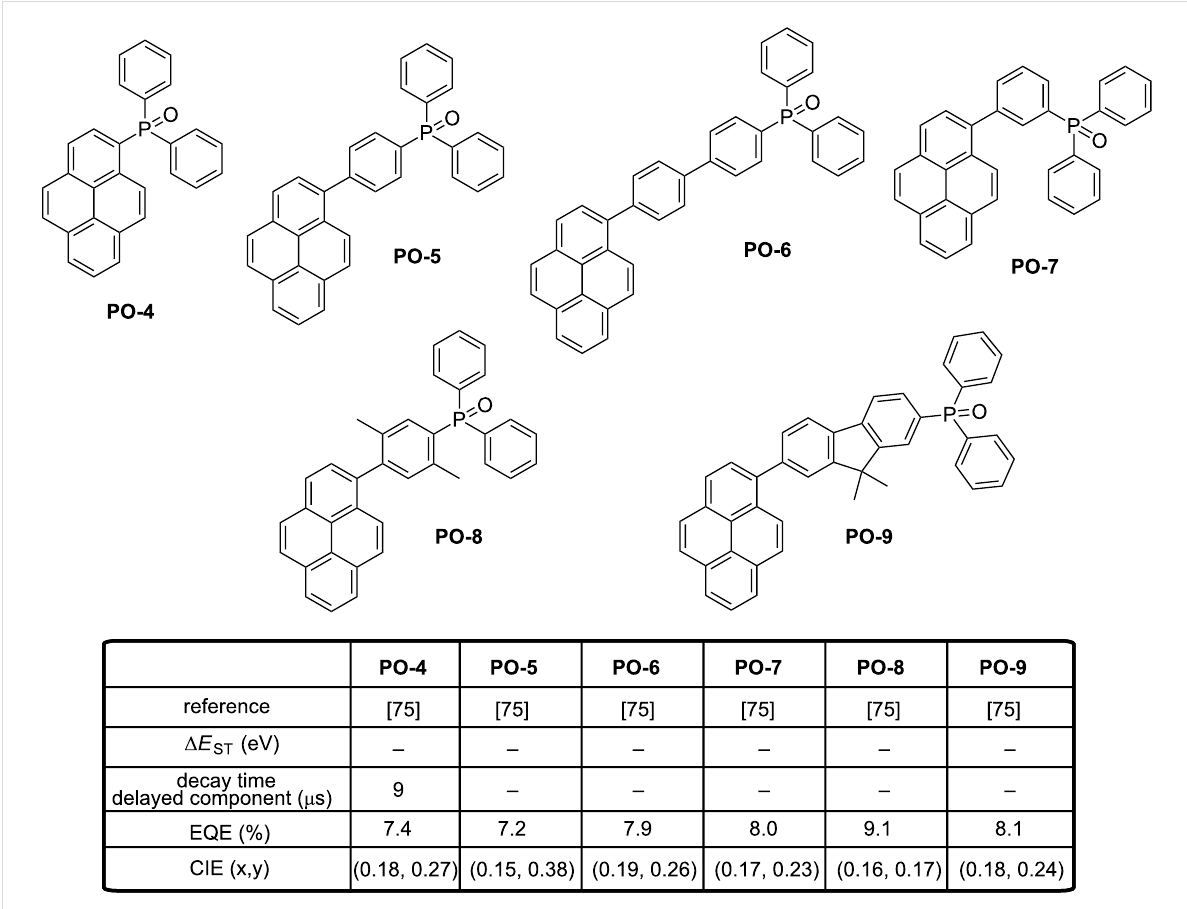
Figure 14: Phosphine oxide-based TADF blue emitters PO-4 – PO-9 .